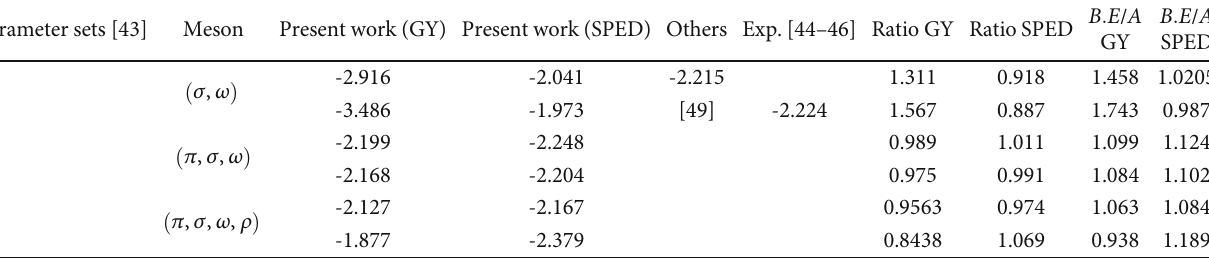
Table 5: The ground-state energy of 2 H nucleus based on OBEP.